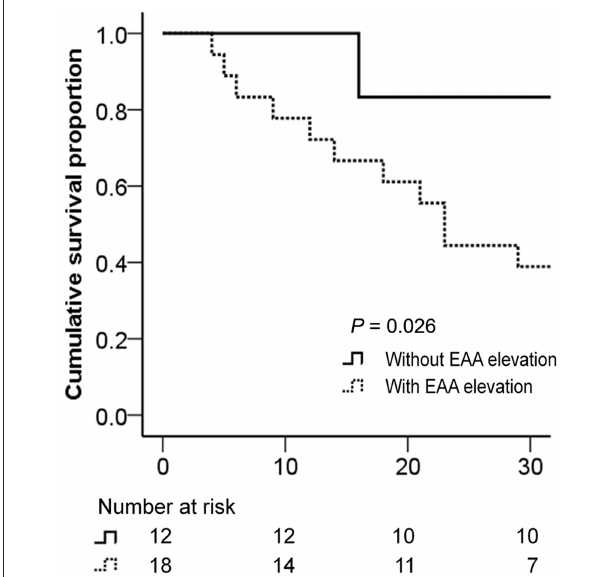
FIGURE 3 | Kaplan–Meier 30-day survival curve for VA-ECMO patients. Patients with or without elevated EAA level at T3 (vs. T1). Study time points: within 24h (T1) and 49–72 (T3) after ECMO initiation. Result of statistical comparison using log-rank test. EAA, endotoxin activity assay; VA-ECMO, venoarterial extracorporeal membrane oxygenation.